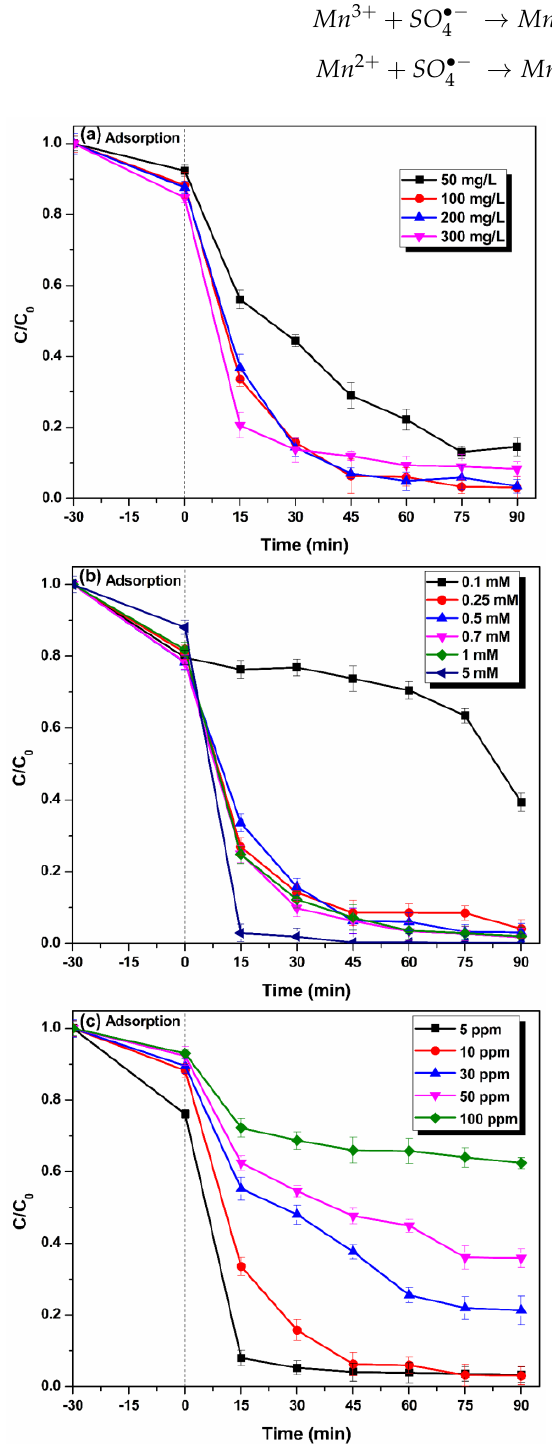
Figure 6. Effects of: ( a ) catalyst dosage using 0.25 mM PMS; ( b ) PMS concentration using 100 mg/L catalyst ( c ) initial pollutant concentration on dye removal efficiency using 0.25 mM PMS and 100 mg/L catalyst.